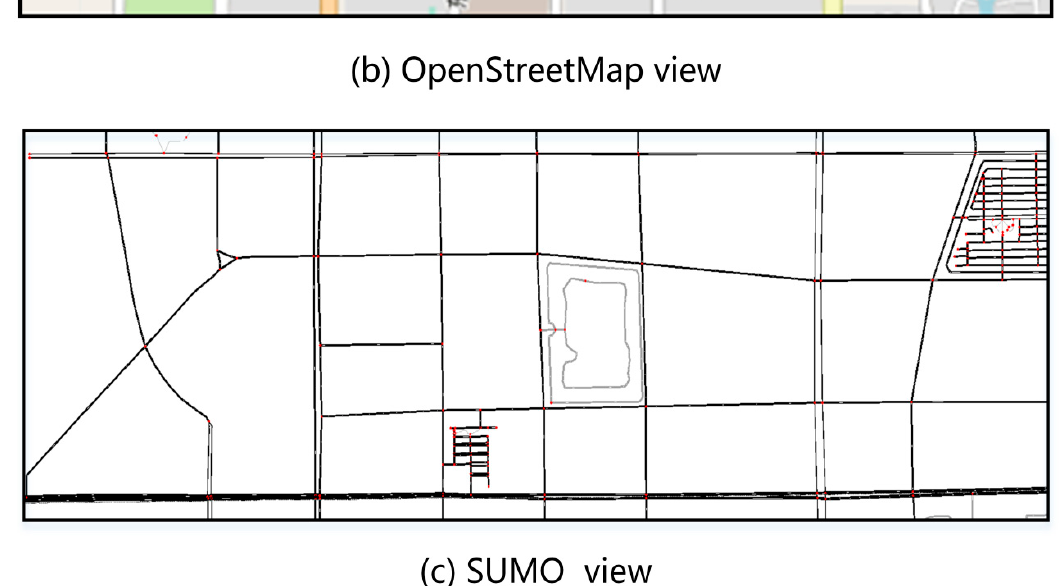
Figure 5. Process of creation of actual road network scenario in the real world. Views of Changsha County (113°6 ′ 34.2 ″ E, 28°15 ′ 28.7 ″ N). After selecting the actual road network scenario (Baidu Map